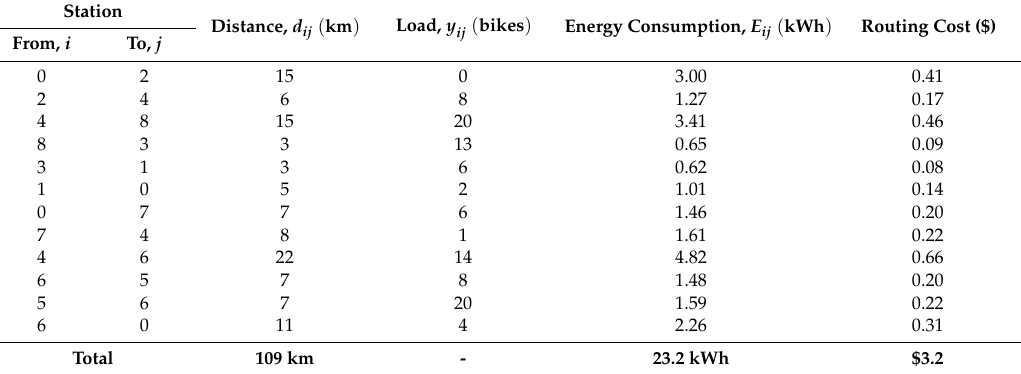
Table 6. Energy consumption and routing cost of the battery electric vehicle (BEV).